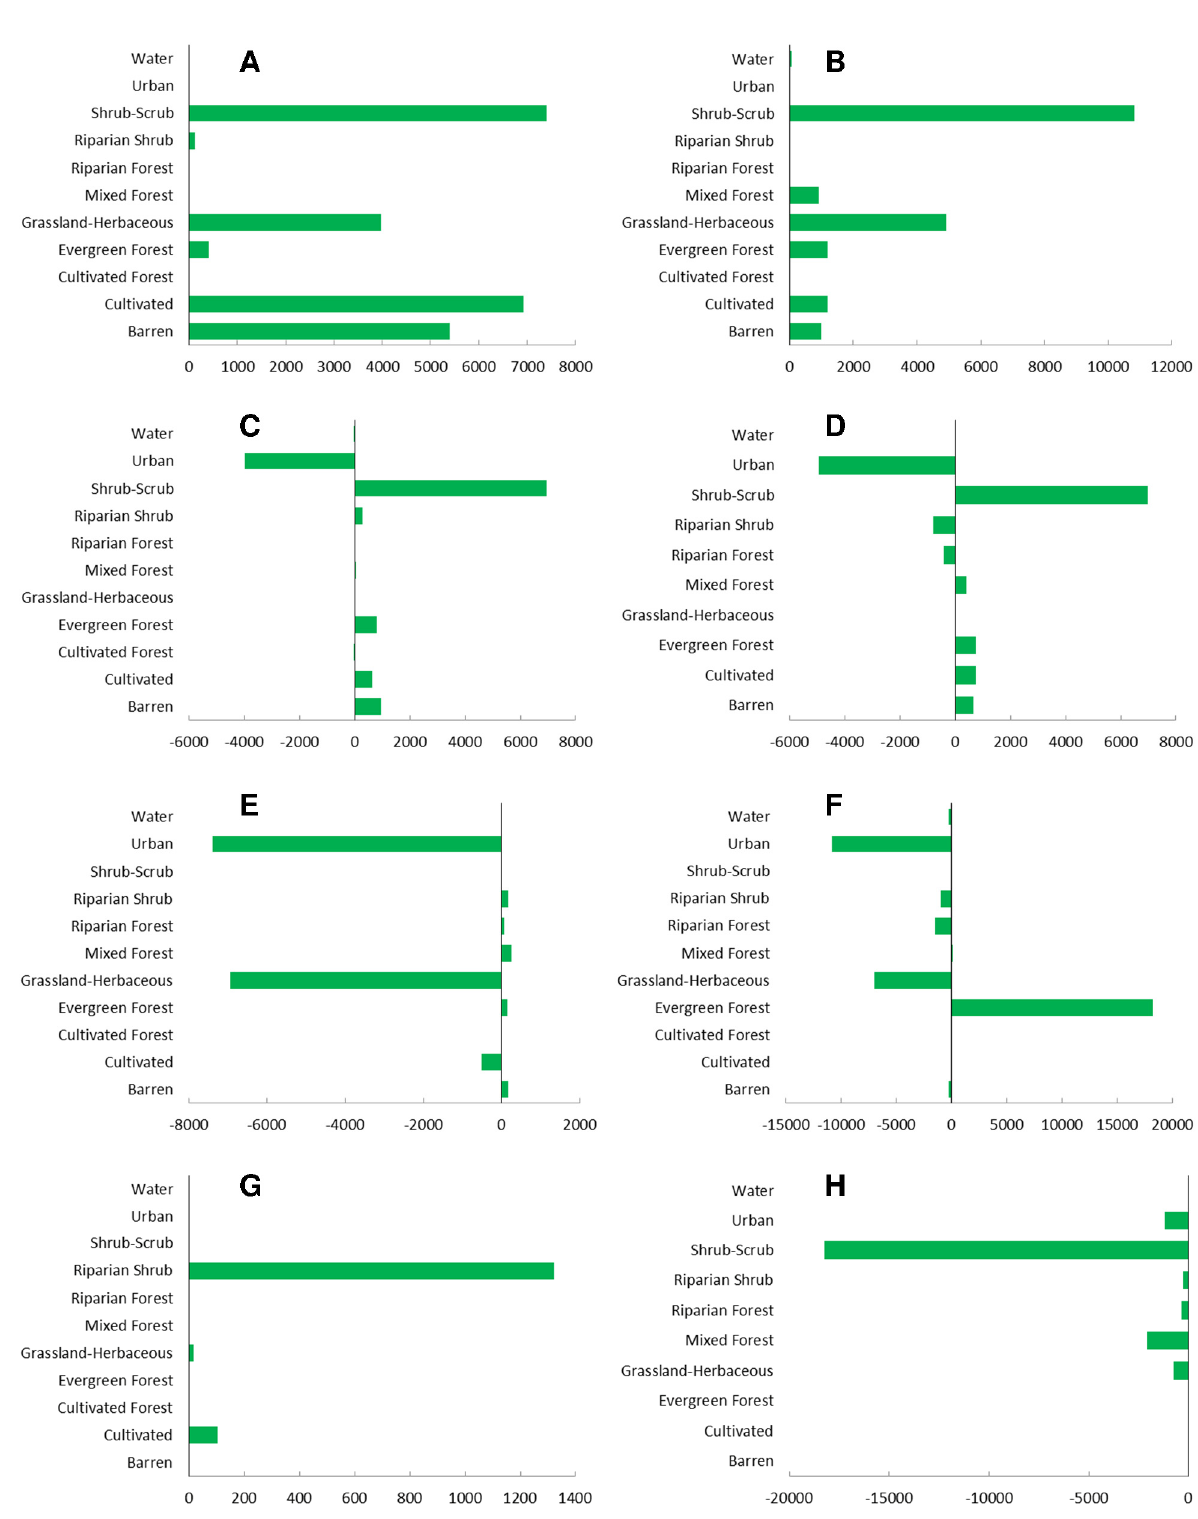
Figure 3. Contributors to net change for five land use and vegetation cover categories with greatest change. Units are in hectares. Mexico ( left ); United States ( right ). ( A ) and ( B ) are for Urban; ( C ) and ( D ), Grassland-Herbaceous; ( E ) and ( F ), Shrub-Scrub; ( G ), Cultivated Forest (only in Mexico); and ( H ), Evergreen Forest (only in the United